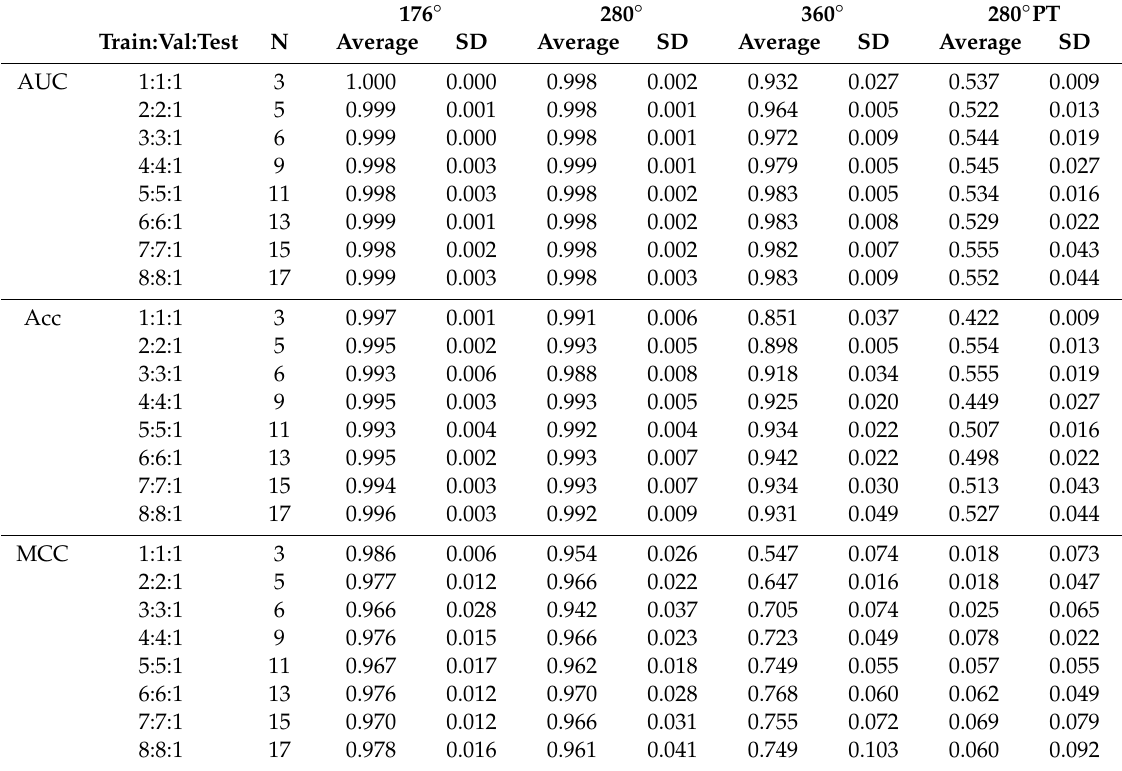
Table 2. Prediction performances with di ff erent angles in the DeepSnap.